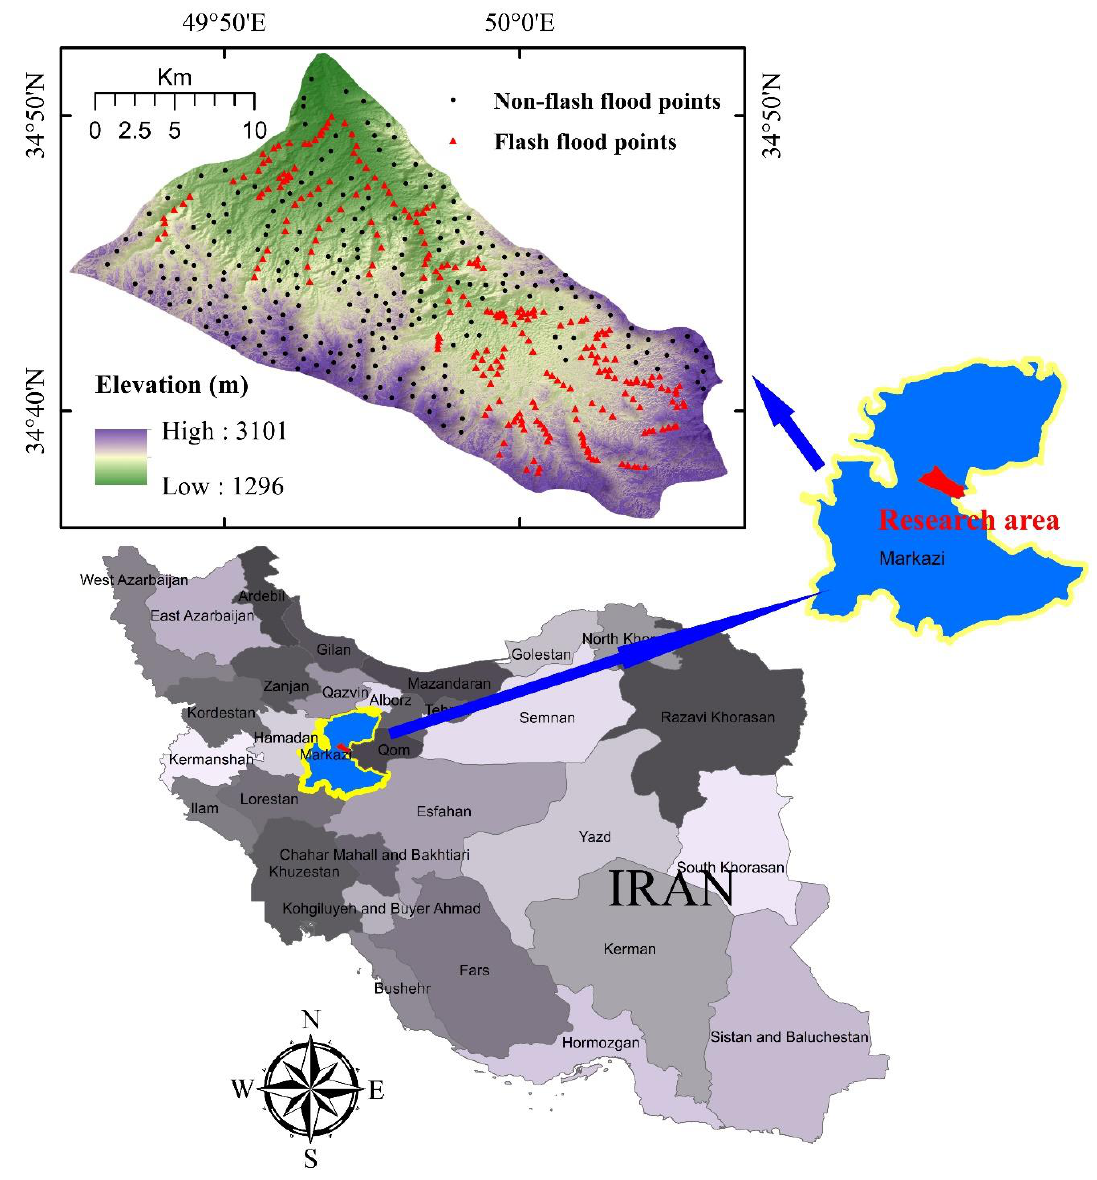
Figure 1. Location of study area.